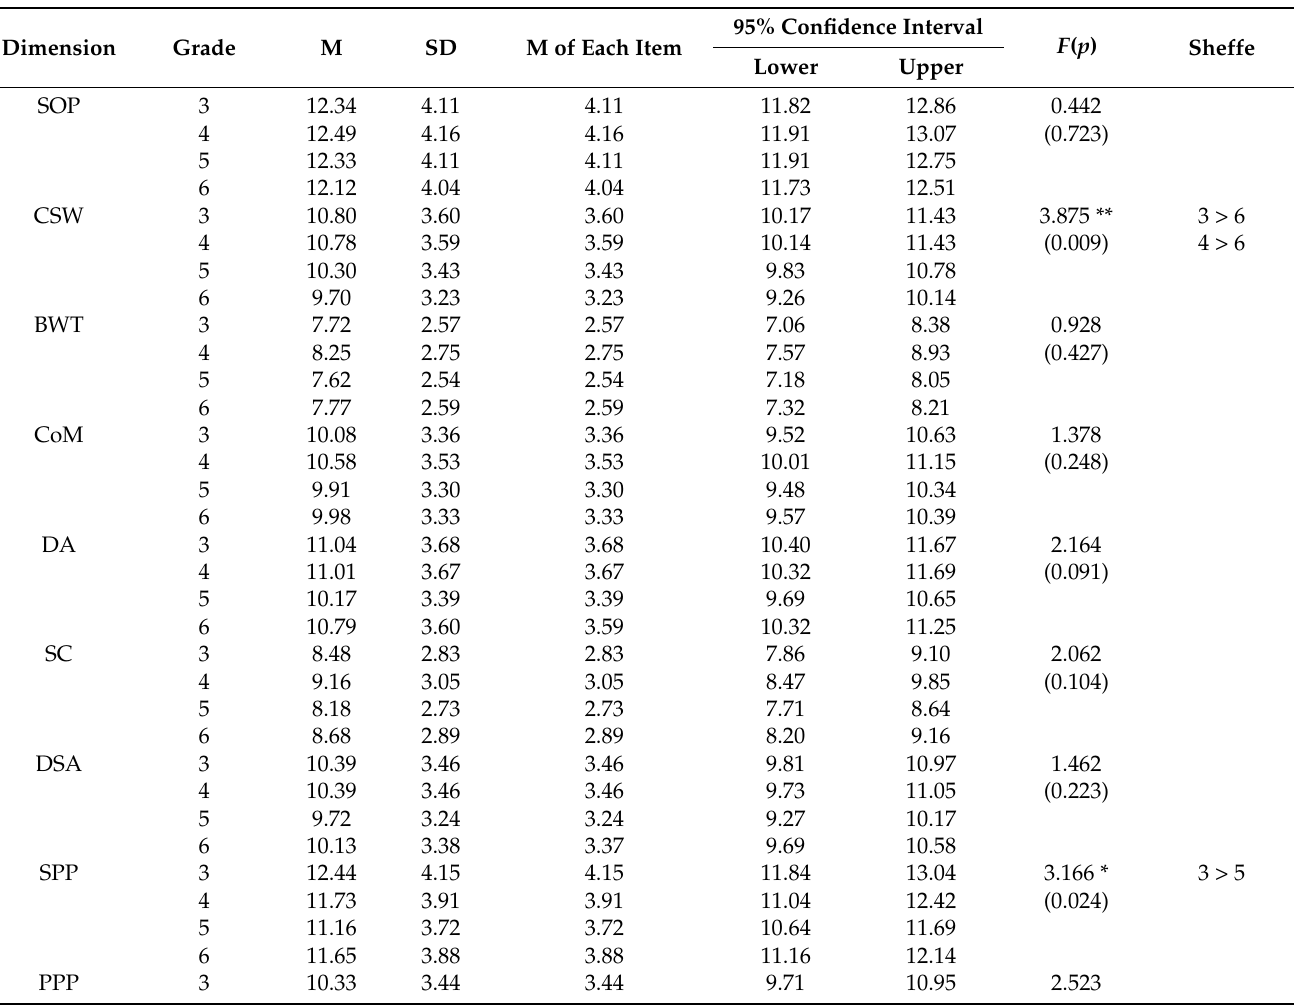
Table 2. The difference in perfectionism by